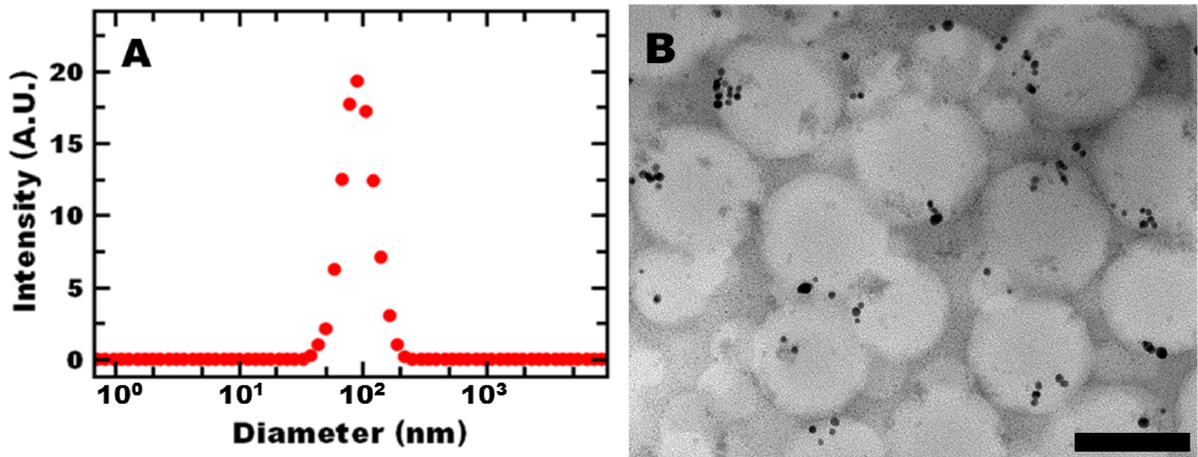
Figure 1. Representative ( A ) DLS (intensity-weighted average of 4 measurements) and ( B ) TEM of PS 7500 nanoreactors with a 100 nm scale bar.